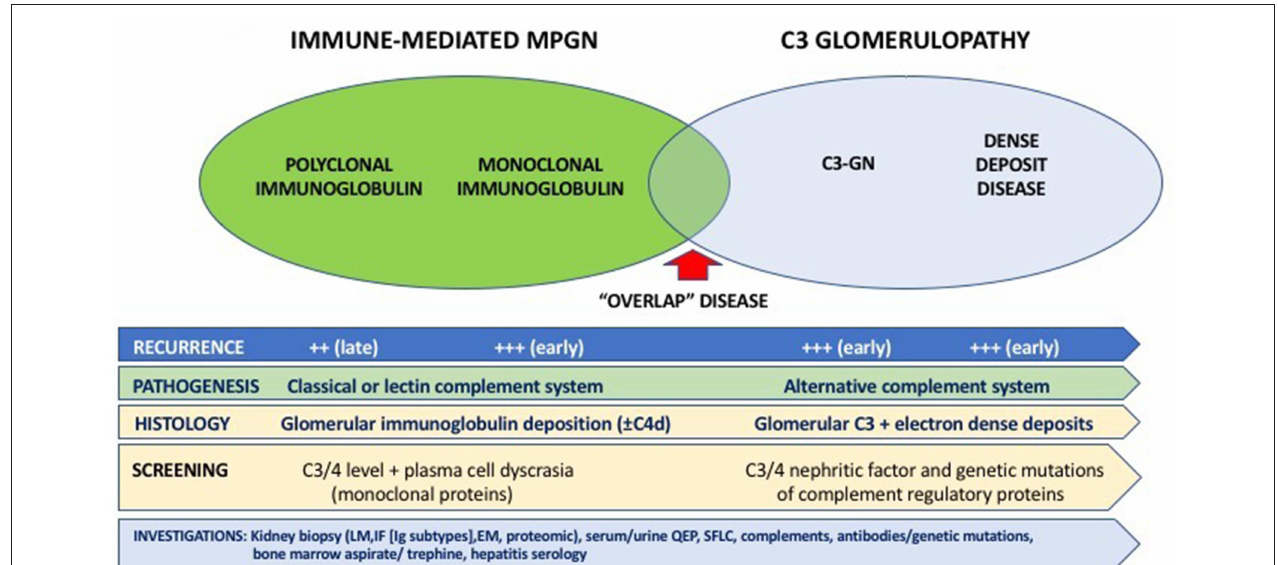
FIGURE 1 | Overview of the classification, pathogenesis, characteristics, and diagnostic assessment of membranoproliferative glomerulonephritis (MPGN).